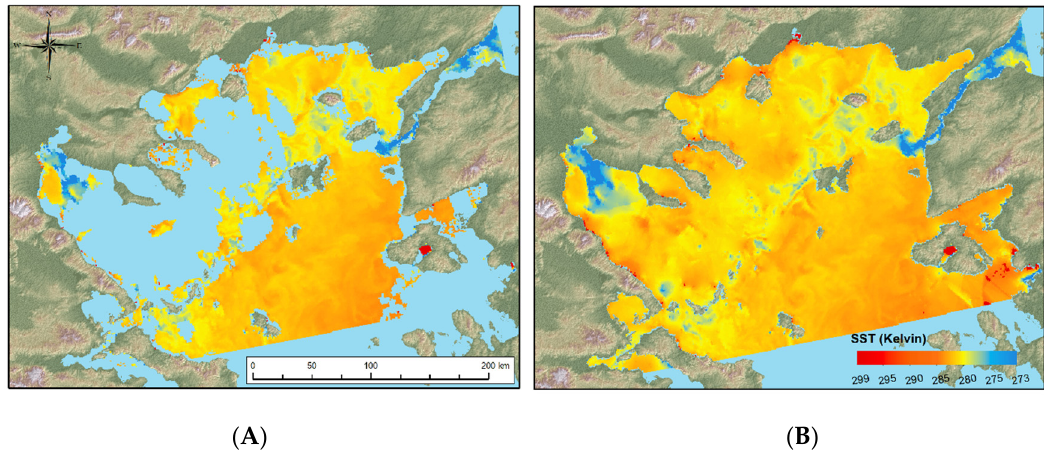
Figure 4. ( A ) SST data from the Sentinel ‐ 3 ′ s SLSTR sensor, after applying invalid pixels (07/05/2020). ( B ) Interpolated data using the Co ‐ Kriging formula SST ~ (T ‐ 1) + (T ‐ 2), meaning SST estimating with information from the 6th and the 5th of May 2020.